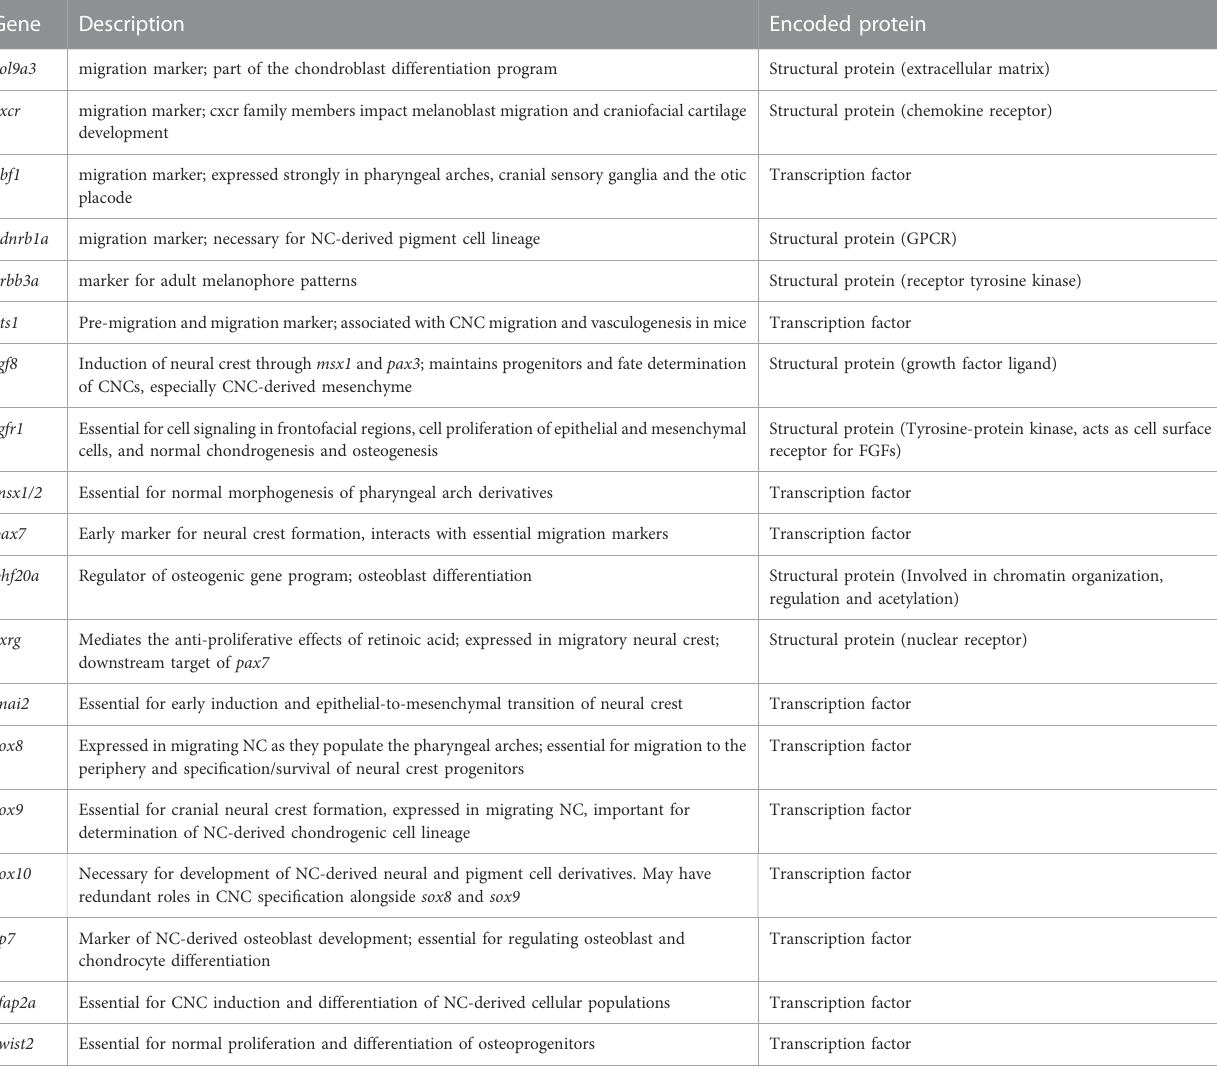
TABLE 1 Functional description of neural crest marker genes implemented in inter- and intra-morphotypic